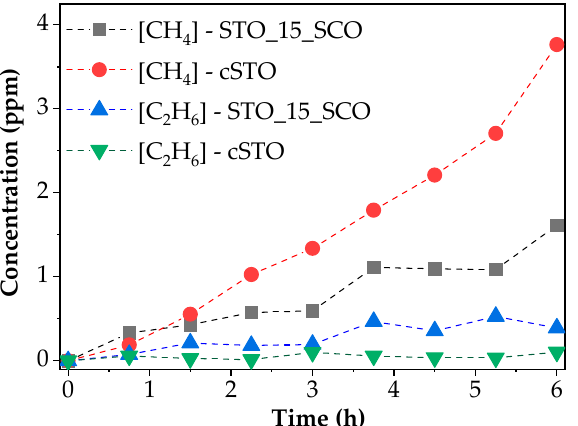
Figure 10. Concentrations of CH 4 and C 2 H 6 formed over time in the presence of CO 2 for the hydrothermally synthesized SrTiO 3 (STO_15_SCO) and commercial SrTiO 3 (cSTO).